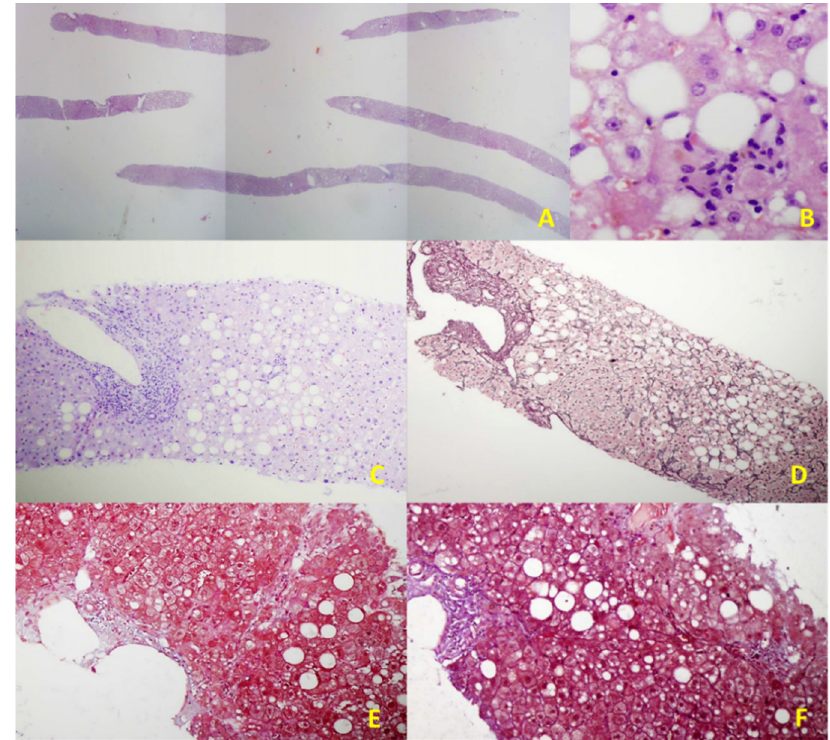
Figure 2. Illustrative histological features of NAFLD in an EUS-LB specimen. ( A ) Up to 75 portal triads per liver specimen obtained by EUS-LB using 19-gauge FNB needle (HE staining, magnification 20×); ( B ) Focal necrosis, macrovesicular steatosis, and ballooning of hepatocytes grade 1. (HE staining, magnification 400×); ( C ) Mild chronic infiltration in portal tract with the preserved limited plate. Panacinar steatosis (up to 30%); (HE staining, magnification 100×); ( D ) Moderate, zone 3 perisinusoidal fibrosis (Brunt, fibrosis stage 1b); (Gomori; magnification 100 × ); ( E ) Mild, zone 3 perisinusoidal fibrosis (Brunt, fibrosis stage 1a); (Masson; magnification 100 × ); ( F ) Bridging fibrosis (Brunt, fibrosis stage 3); (Masson; magnification 100×).